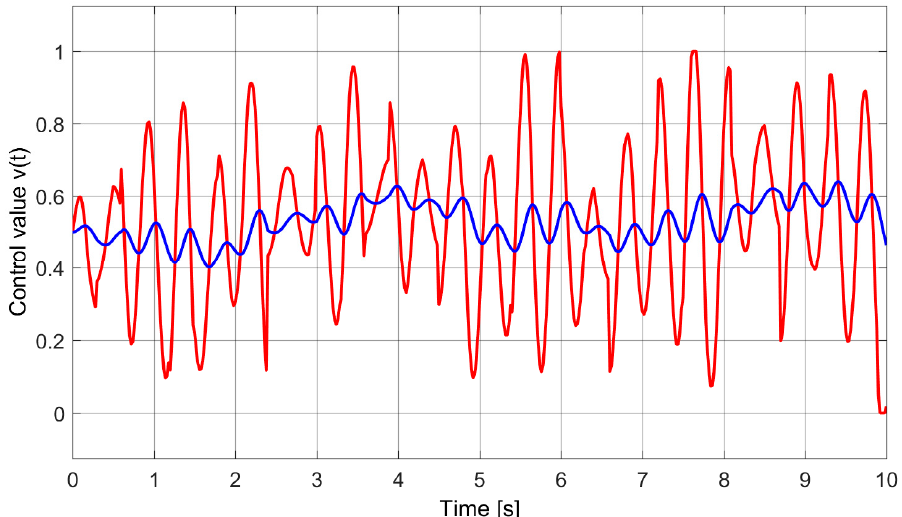
Figure 4. An example of two control strategies with a strongly differentiated effort. Value of effort for aggressive strategy Q K = 0.32 and for a conservative strategy Q K = 0.029 [19].